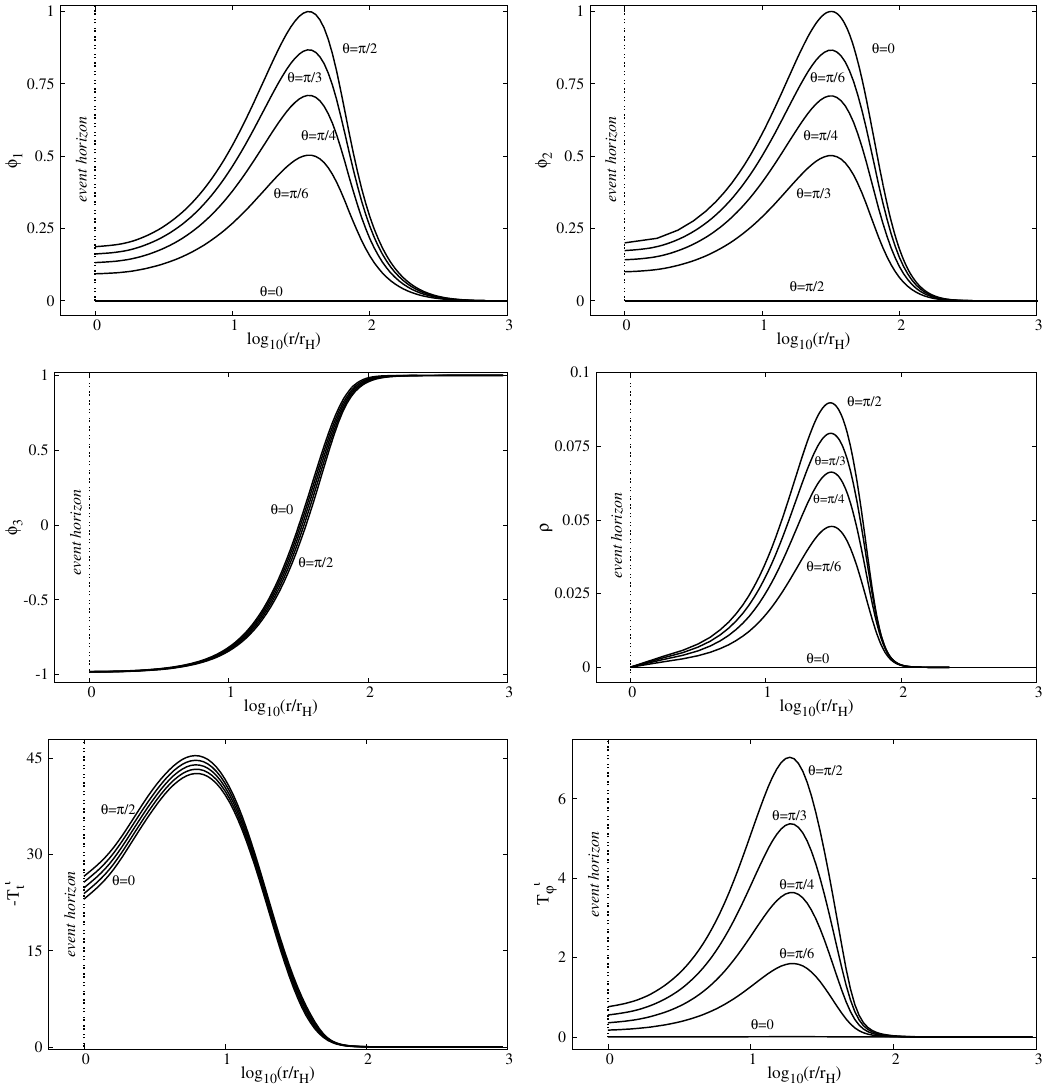
Figure 3 . The functions (cid:30) a and the baryon charge density (cid:26) , energy and angular momentum densities are shown for Skerrmions on a Kerr background with M Kerr = 0 : 04 and (cid:10) H = 0 : 95. cannot be arbitrary large. A linearization in the far-(cid:12)eld of the (cid:12)eld equation for = (cid:25) + i(cid:25) 1 2